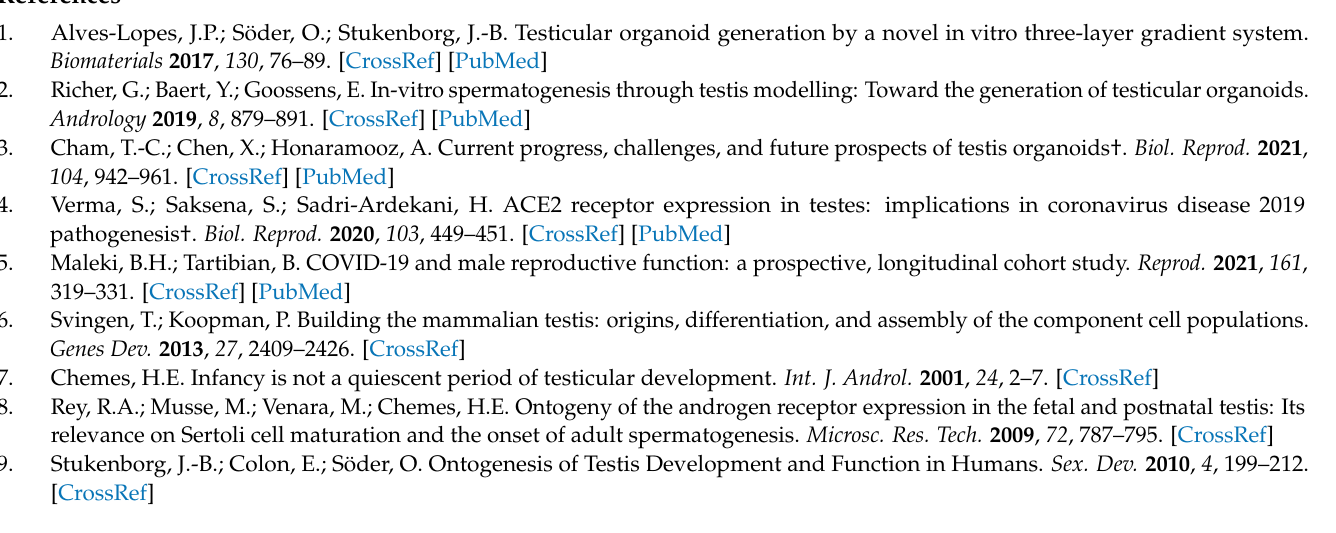
istry. Figure S1: Negative controls for secondary antibodies. Figure S2: Representative histological micrographs of testis organoids cultured in media supplemented with either fetal bovine serum (FBS) or a combined supplementation of FBS and knock-out serum replacement